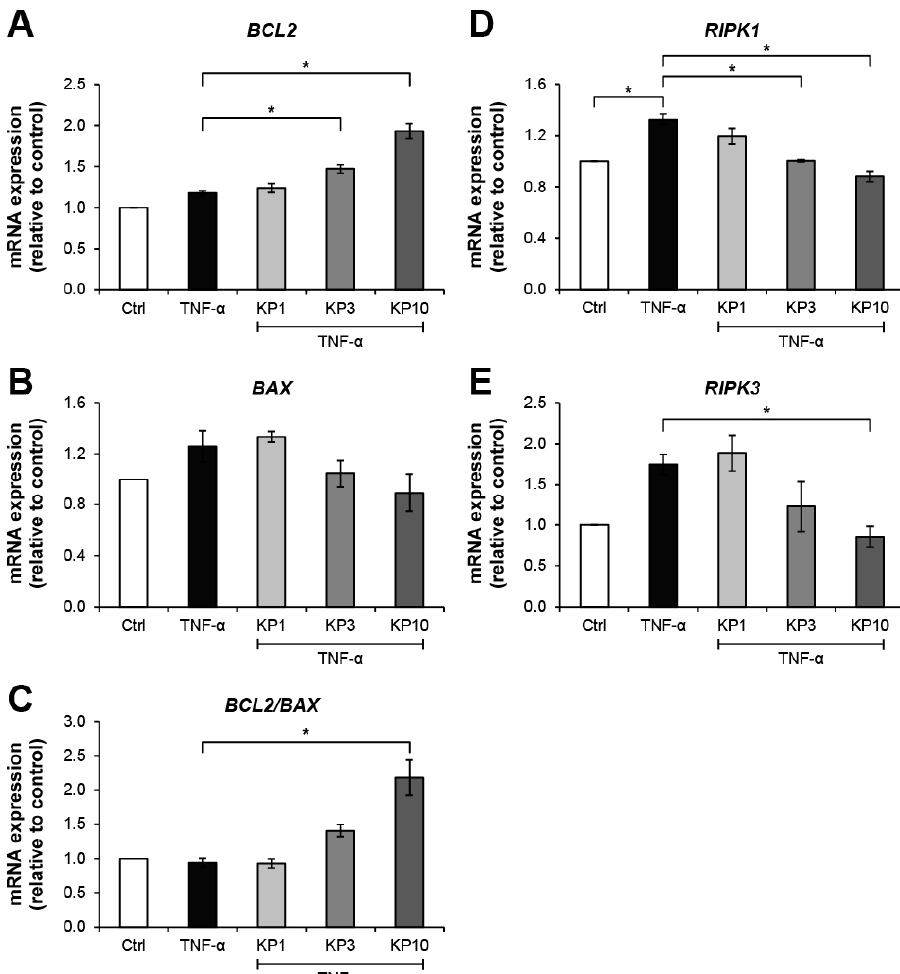
Figure 5. KP extract suppresses the expressions of necroptosis-related genes but promotes the anti-apoptosis gene. SW1353 cells were pretreated with TNF- α 10 ng/mL for 2 h to trigger cell death-associated gene expression, followed by a co-treatment with KP extract (1, 3, and 10 μ g/mL) for 24 h. The untreated group was left as a control (Ctrl). In KP extract co-treated groups, an increasing trend of anti-apoptosis process was observed from the upregulation of BCL2 gene expression ( A ) and the suppression of BAX gene expression ( B ), which contributed to the increasing ratio of BCL2 : BAX gene expressions ( C ). The upregulation of necroptosis-related gene expression, RIPK1 ( D ) and RIPK3 ( E ), induced by TNF- α was significantly suppressed by the KP extract at 10 µ g/mL. Results represent mean ± SD of three independent experiments. One-way ANOVA followed by the post hoc Tukey multiple comparison test was used to analyze the statistical difference (* p <